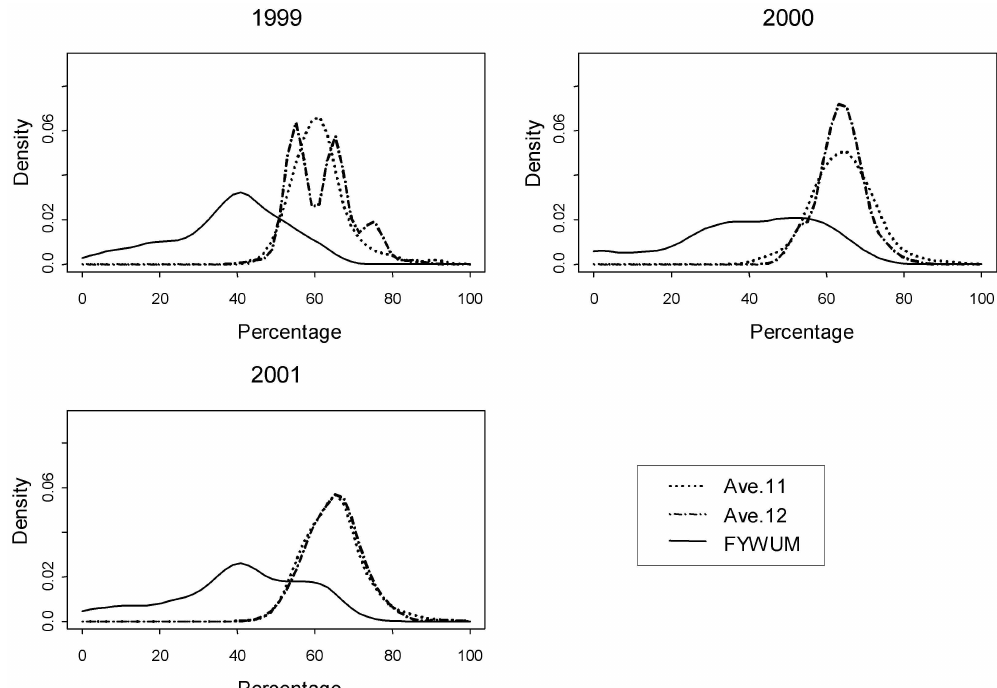
Figure 8: Kernel densities of the Grade 11 and Grade 12 mark variables and the FYWUM of the Test Battery 3 data sets for 1999, 2000 and